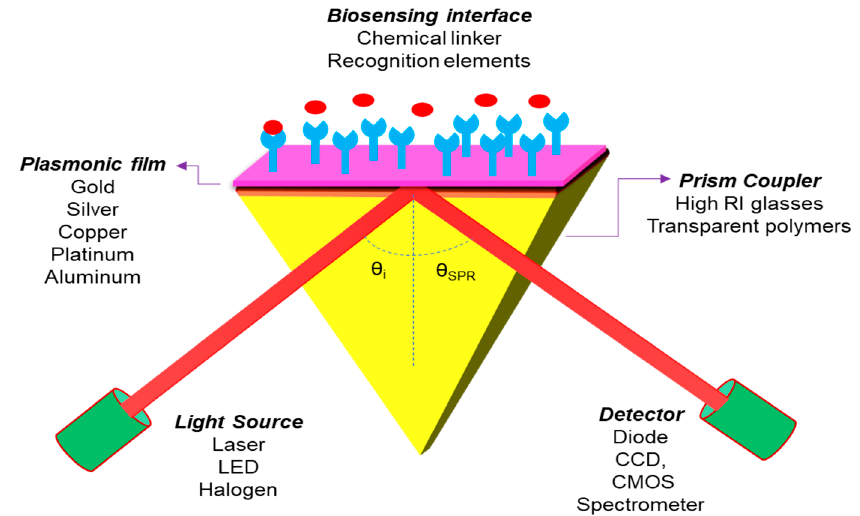
Figure 8. Sketch diagram for the Kretschmann configuration of an SPR sensor.